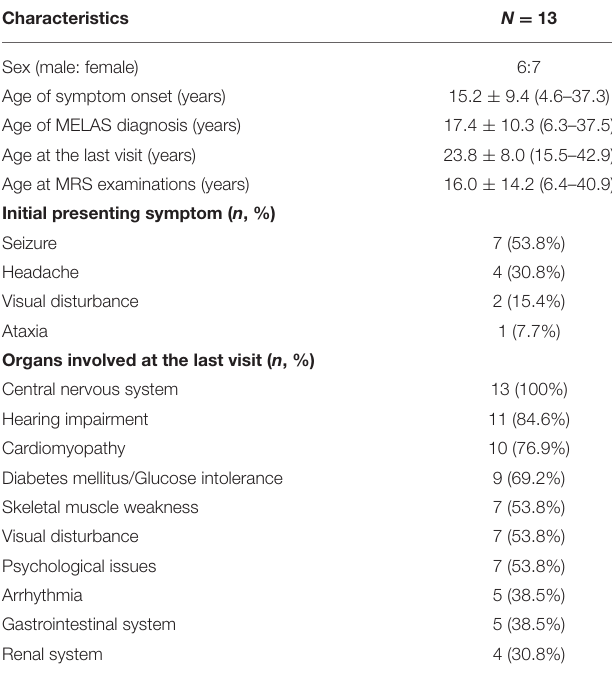
TABLE 1 | Patient characteristics. TABLE 2 | Correlation of serum biomarkers and magnetic resonance